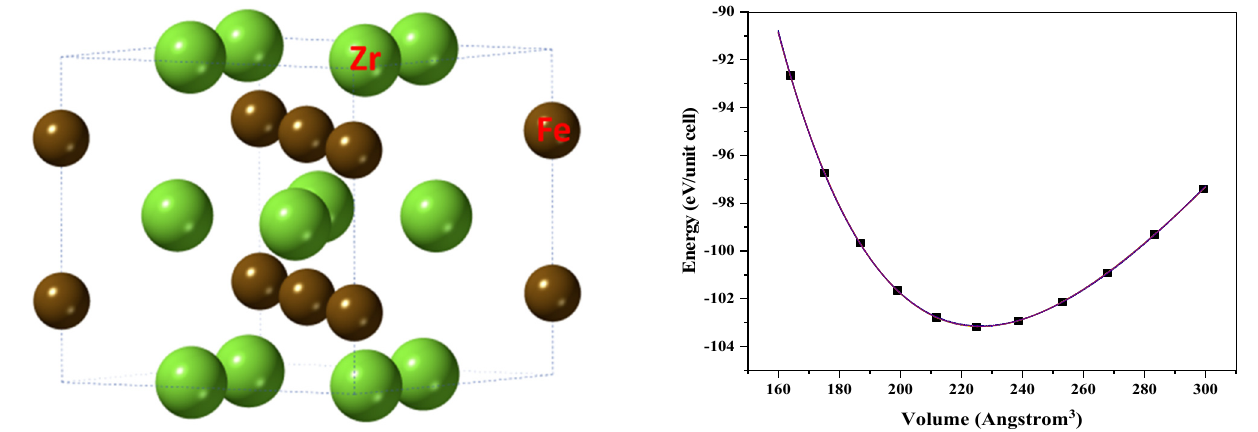
Figure 2. The lattice structure ( left panel ) and the total energy as a function of cell volume ( right panel ) for Zr 2 Fe. Table 1. Calculated cell parameters together with measurements, including lattice parameters a , c (Å). The fitting errors estimated by |Calc-Expt|/Calc are also shown. Calc. Expt. [26] Error (%)